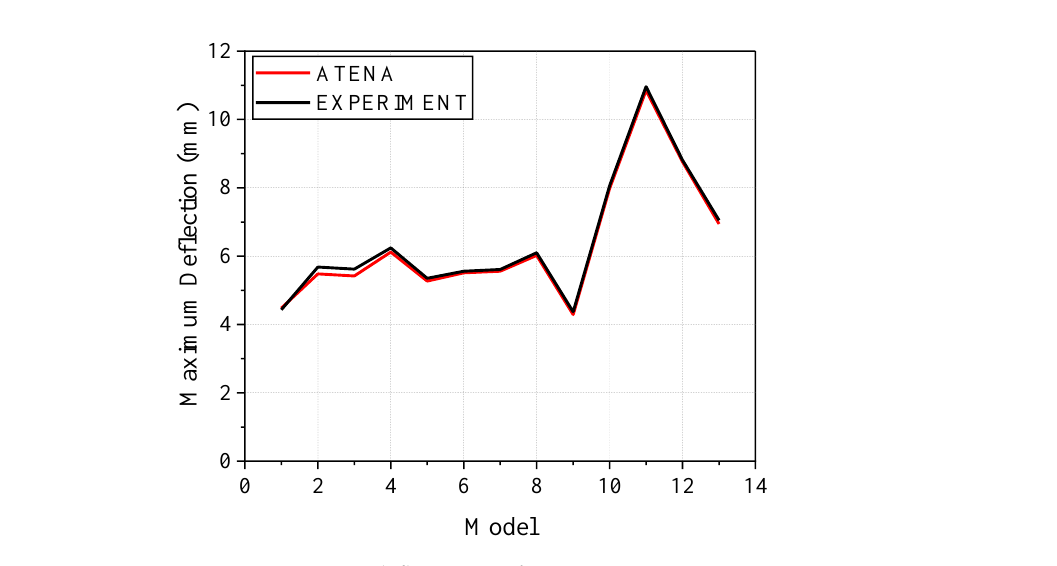
Figure 5. Maximum deflection verification. Table 6. Error estimation for maximum deflection.